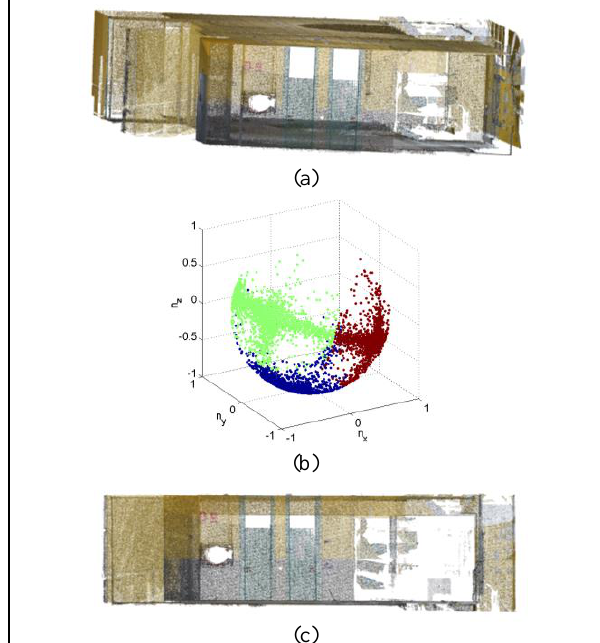
Figure 2. The normal vectors of an indoor point cloud (a) form three clusters corresponding to the direction of the walls and floors/ceilings (b). The cluster centres are used to estimate the rotation parameters that align the point cloud